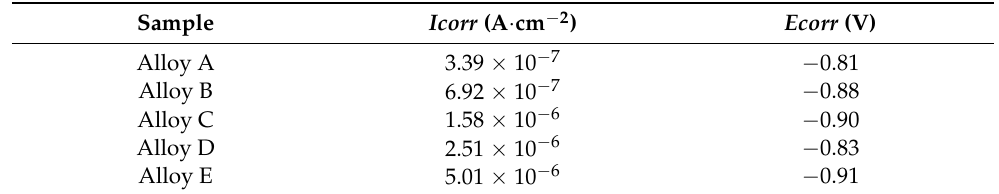
Table 5. The electrochemical fitting parameters of alloys A–E.